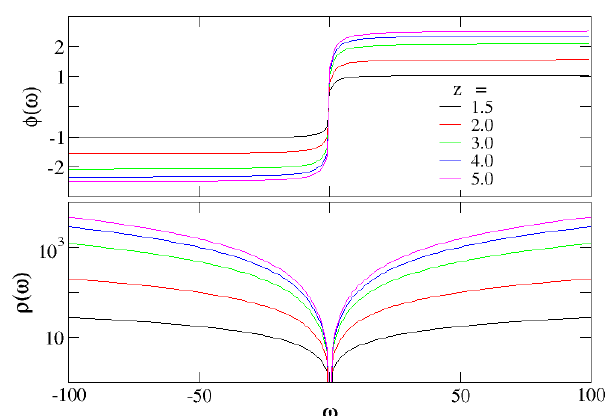
Figure 2. ρ ( ω ) and φ ( ω ) . Radial part (a) and phase (b) of the complex function f ( ω ) as defined by Equation (36). Notice that ρ ( ω ) and φ ( ω ) are real functions of a real